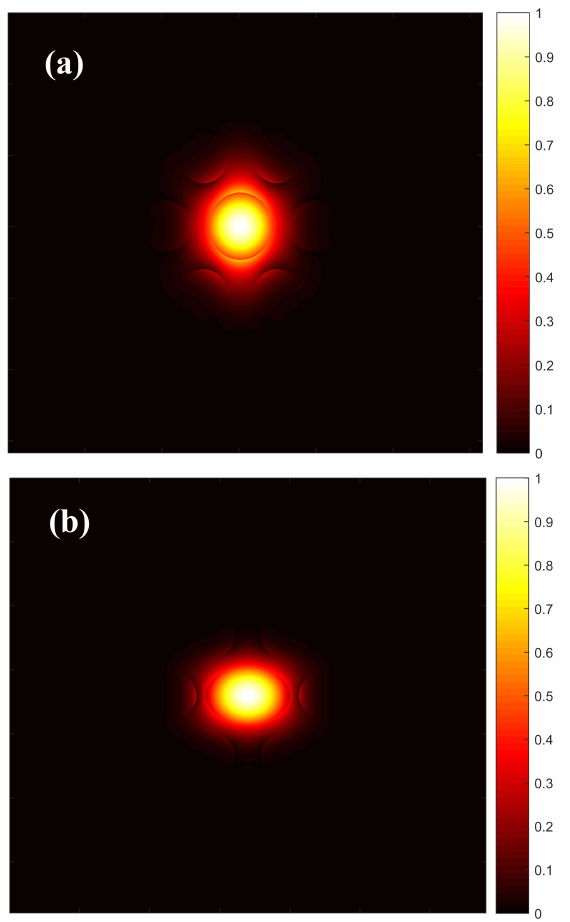
Figure 6. Intensity distribution of fundamental guided mode in ( a ) C-PCF with d / Λ = 0.692 , d c / Λ = 0.876 and Λ = 0.867 µ m, and ( b ) E-PCF with b / a = 0.75 and a = 1 µ m with a 1550 nm